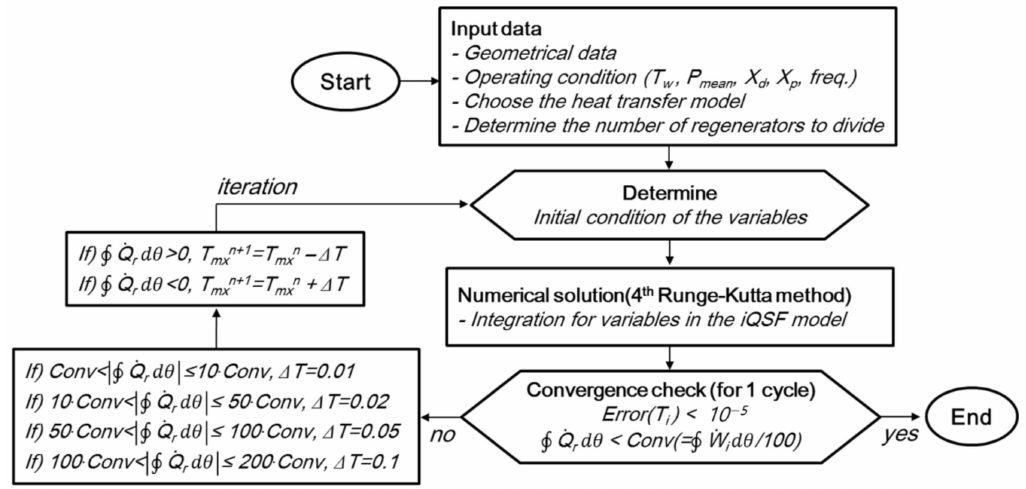
Figure 6. Flow chart of the calculation procedure of the iQSF model.